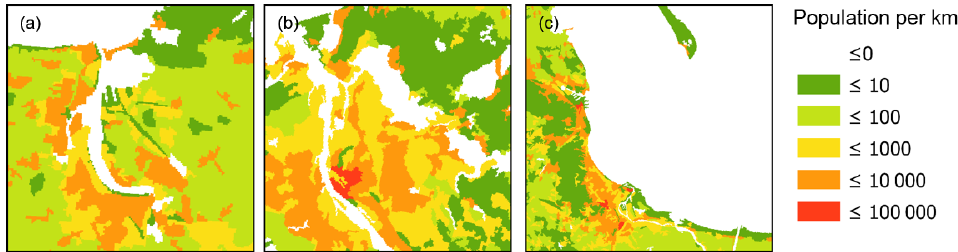
Figure 4. Population Density per square kilometre as derived from Gallego (2010) in (a) Rostock, (b) Riga and (c) Gda´nsk–Gdynia. Maps are created using © 2018 ESRI Inc. ArcGIS Pro 2.3.2. Table 3. Statistical data for 2012 to refine population distribution in the research domains. Population (1000 habitants) Employment Commuter Port work Port turnover City statistics CLC d rate (habitants) (no. workers) (Mio. t) Rostock 203